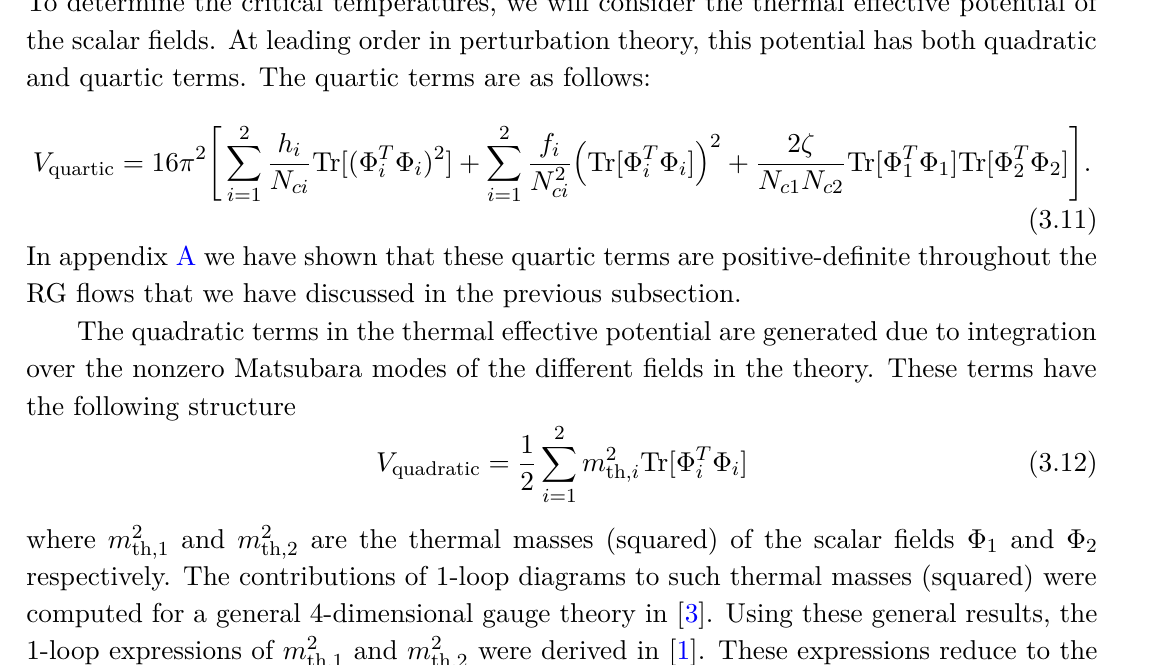
Figure 3. RG flow for λ = 0 . 001 , on the fixed circle. In the IR limit ( t → −∞ ) they flow to a fixed point where the two sectors are